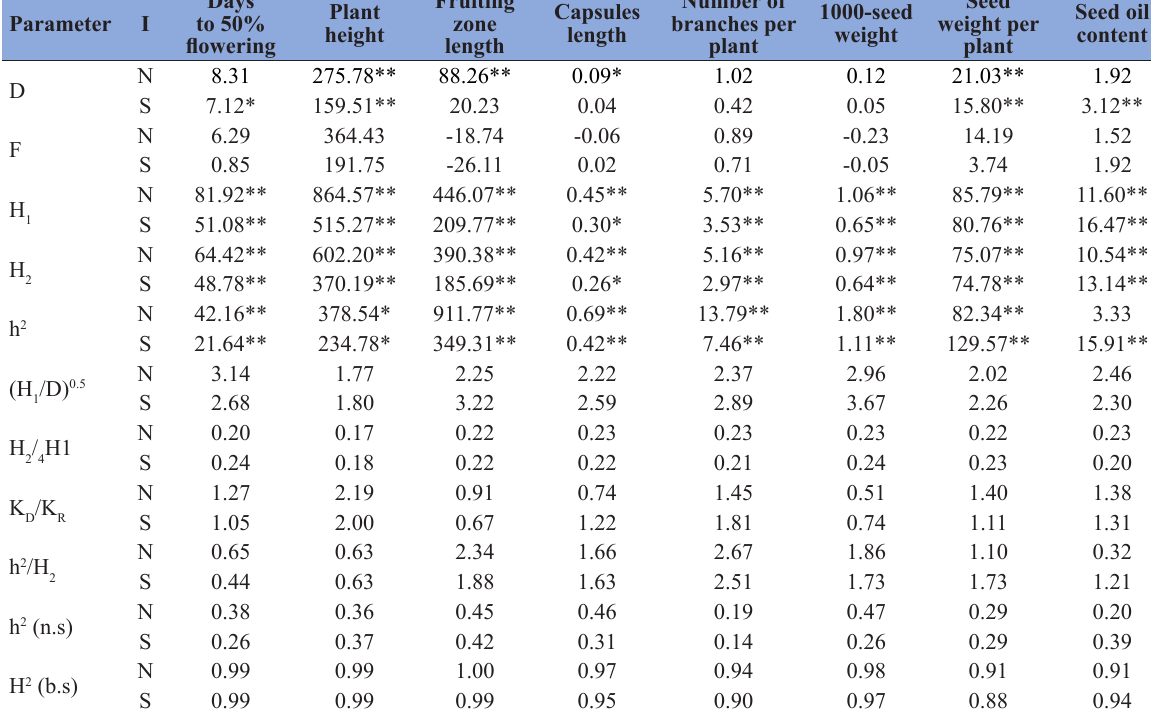
Table 12. Components of the genetic variance and their ratios (Hayman 1954b) for all studied traits under normal irrigation (N) and water stress conditions (S) in 2019 season